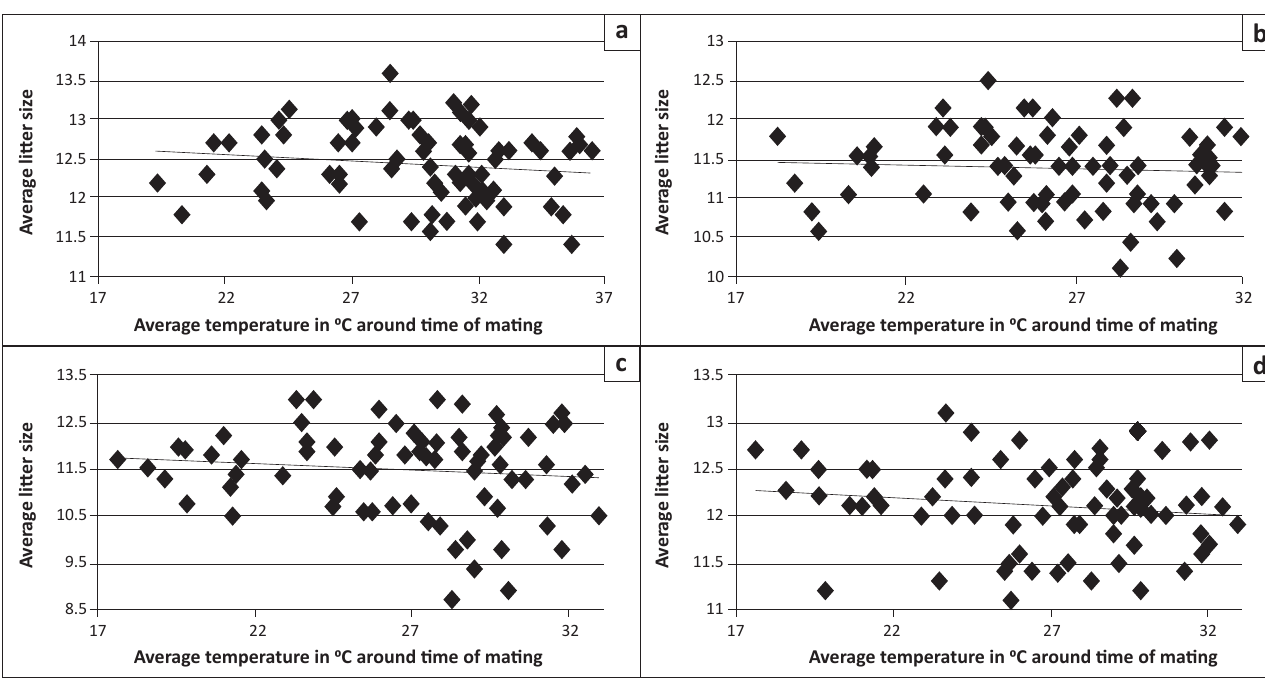
FIGURE 1: Farrowing rate at various ambient temperatures around the time of mating. (a) Breeding unit 1, (b) breeding unit 2, (c) breeding unit 3 and (d) breeding unit 4.